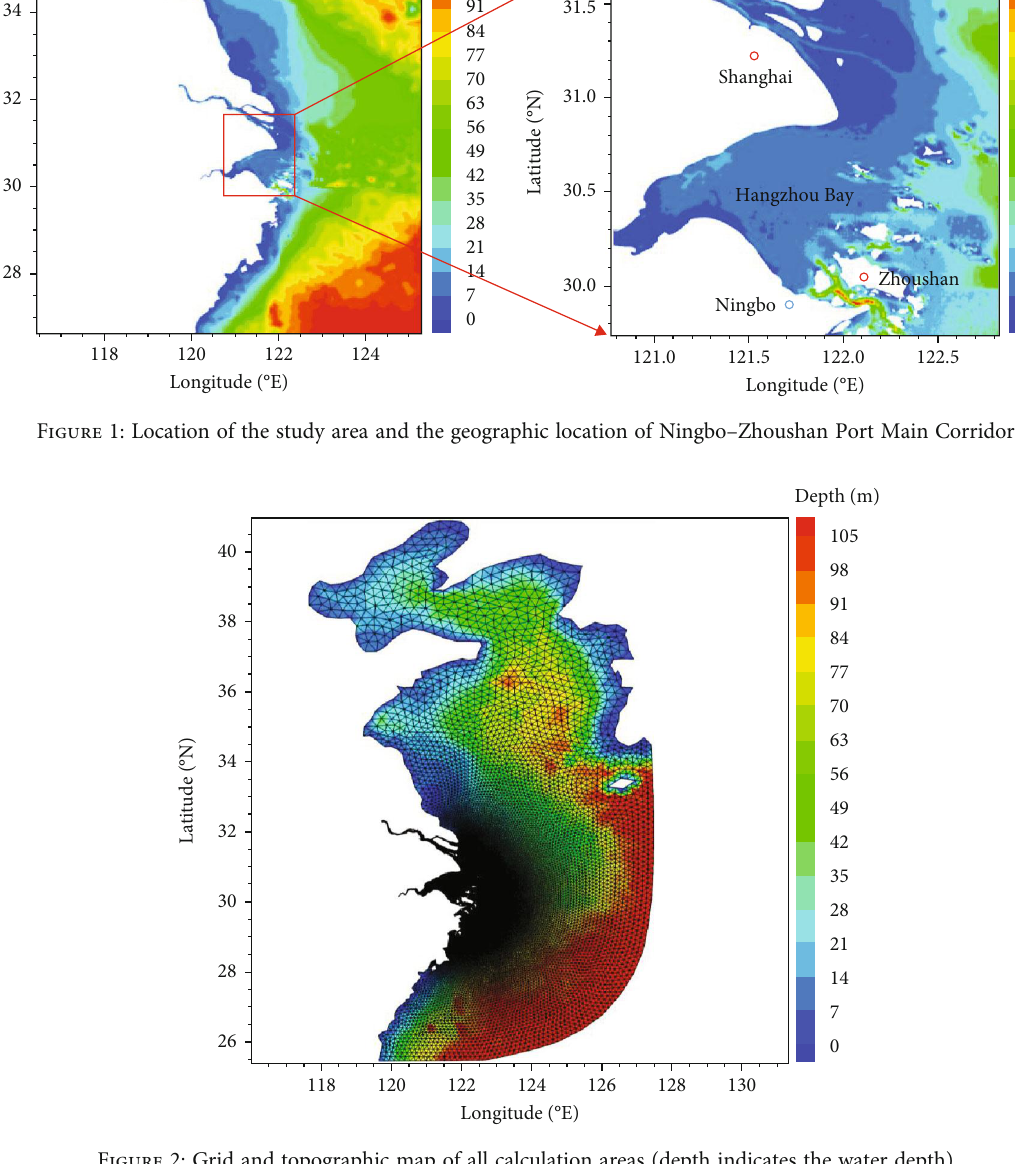
Figure 2: Grid and topographic map of all calculation areas (depth indicates the water